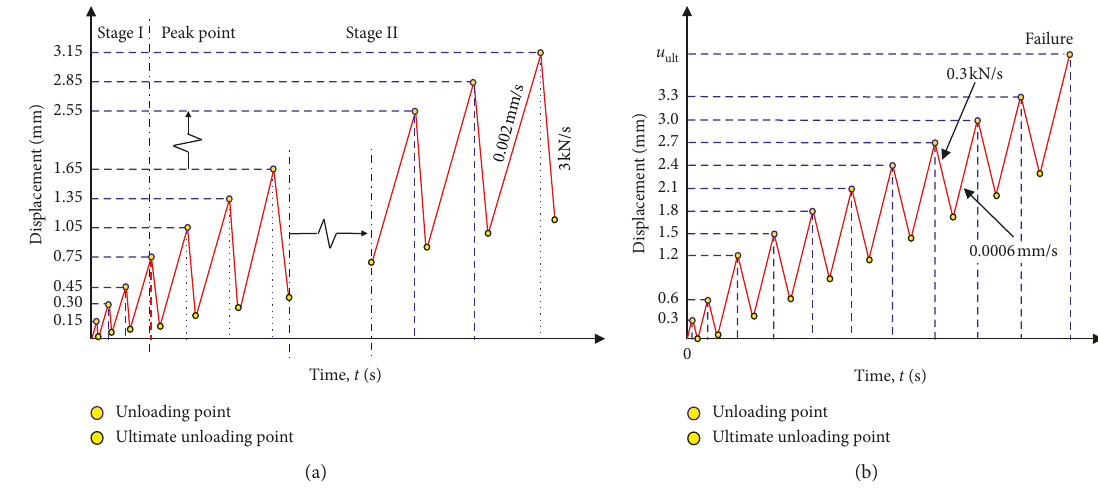
Figure 3: Schematic diagram of cyclic loading procedure. (a) Under compression. (b) Under